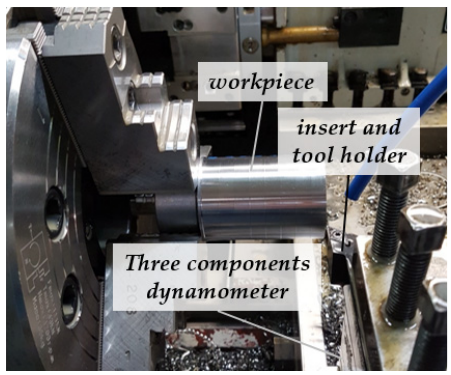
Figure 3. Experimental rig.